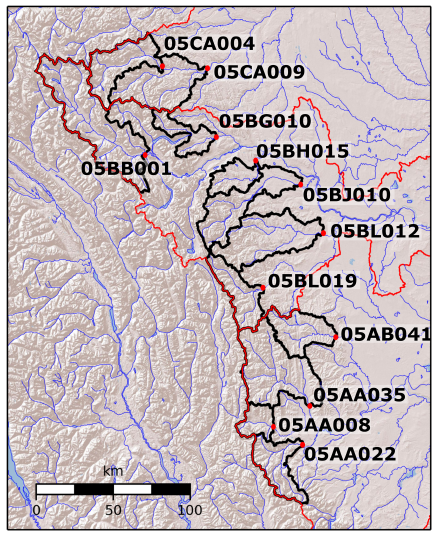
Figure 2. Map showing the locations of the river gauges used in this study and the corresponding river basins (black lines). The red lines represent the Red Deer (north), Bow (middle) and Oldman (south) river basins. The general location of this area is shown in Fig.